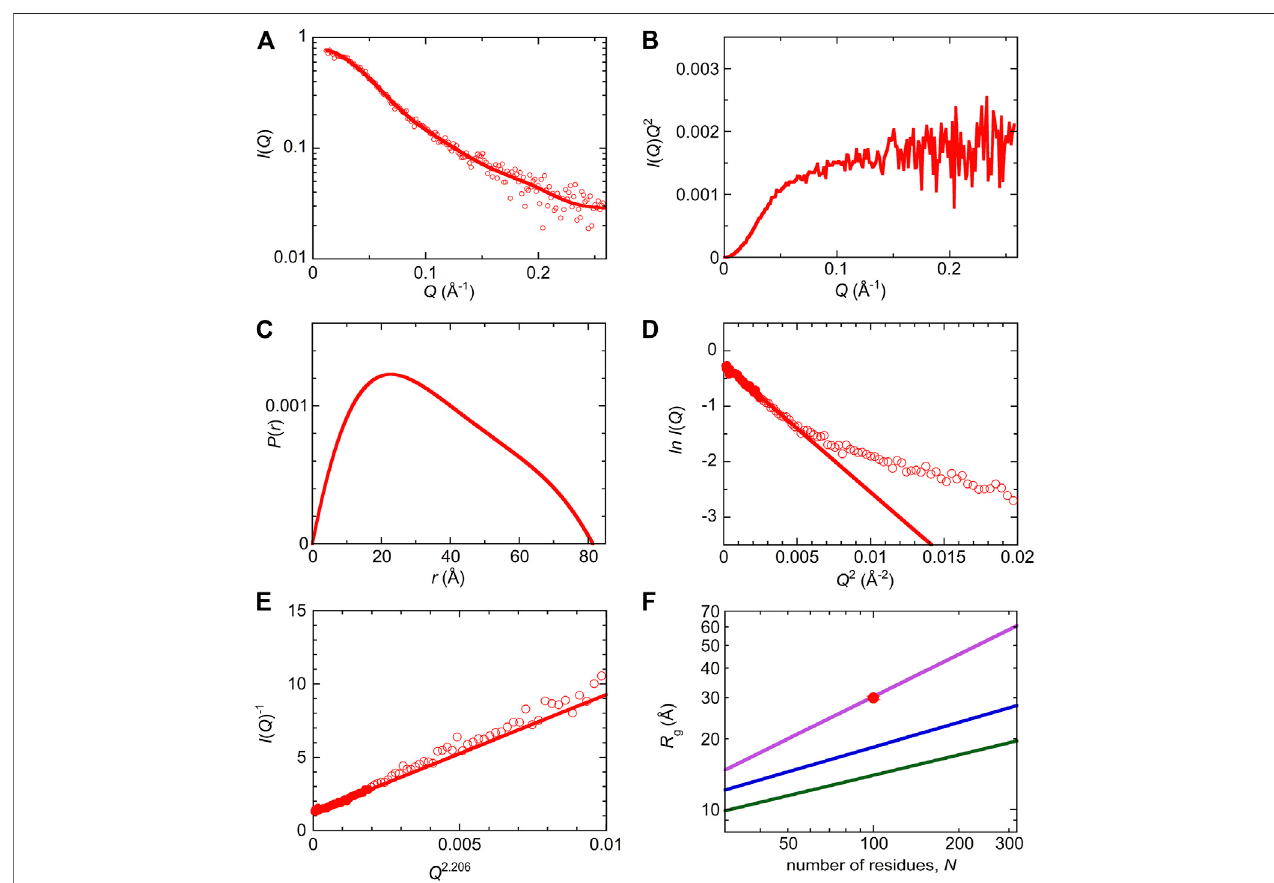
FIGURE4| SAXSanalysisofwild-typeInt8. (A) Theln I ( Q )versus Q plot.ThecontinuouslinewasobtainedbytheEOM fi t.Theintensityisshowninanarbitraryunit. (B) Kratky plot. (C) A pair-distance distribution function, P ( r ). (D) Guinier plot. The continuous line was obtained by Guinier approximation. (E) The I ( Q ) − 1 versus Q 2.206 plot. The continuous line was obtained by fi tting to the Debye function for a random coil. (F) Scaling relationship for the native (green), intermediate (blue), and unfolded state (purple). The red circle shows the R g of Int8 obtained by fi tting to the Debye